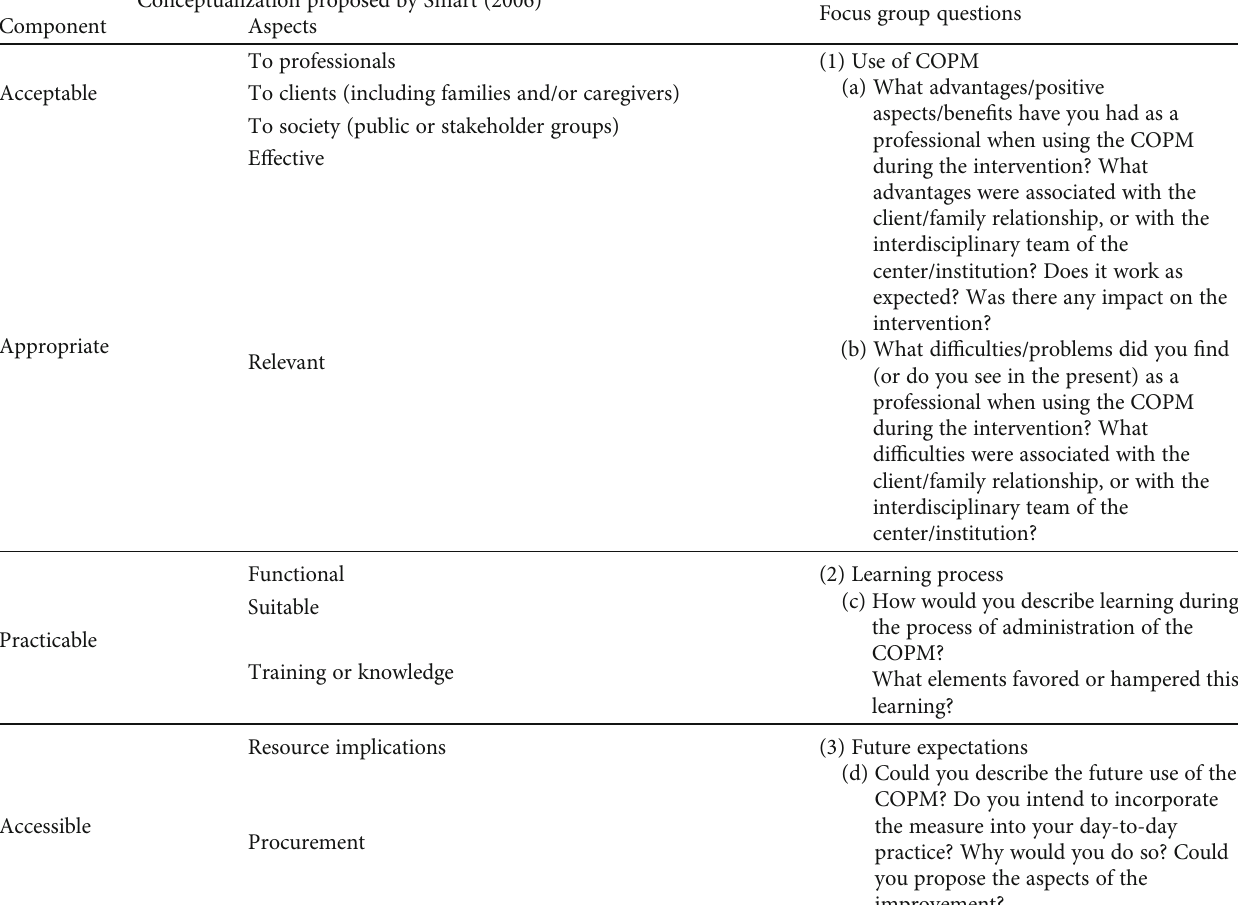
Table 3: Clinical utility conceptualization, themes, and focus group